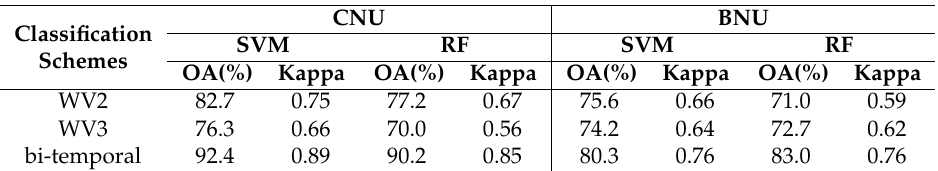
Table 7. Classification results with single-date images and bi-temporal images using the SVM and RF methods in the CNU and BNU areas. OA: overall